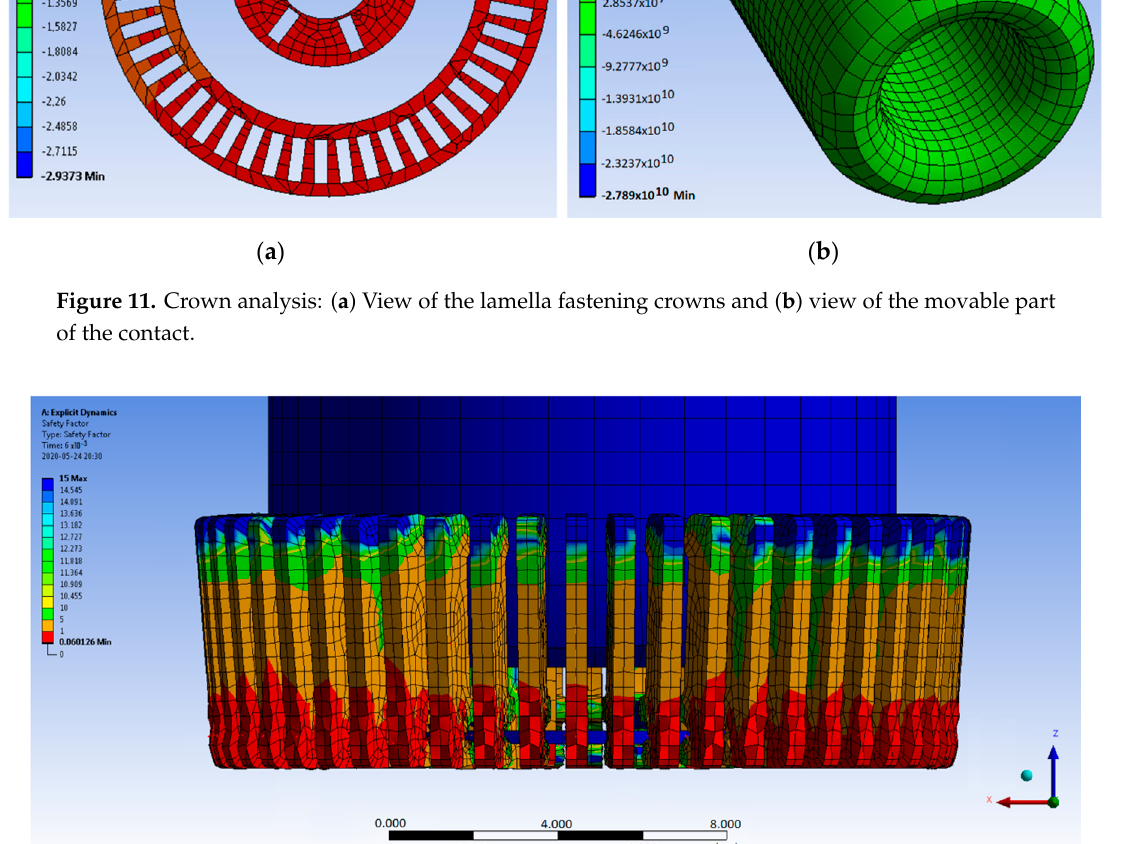
( b ) Figure 13. Diagrams of the tulip contact motion analysis: ( a ) Energy summary—normal operation and ( b ) energy summary—contact destruction.